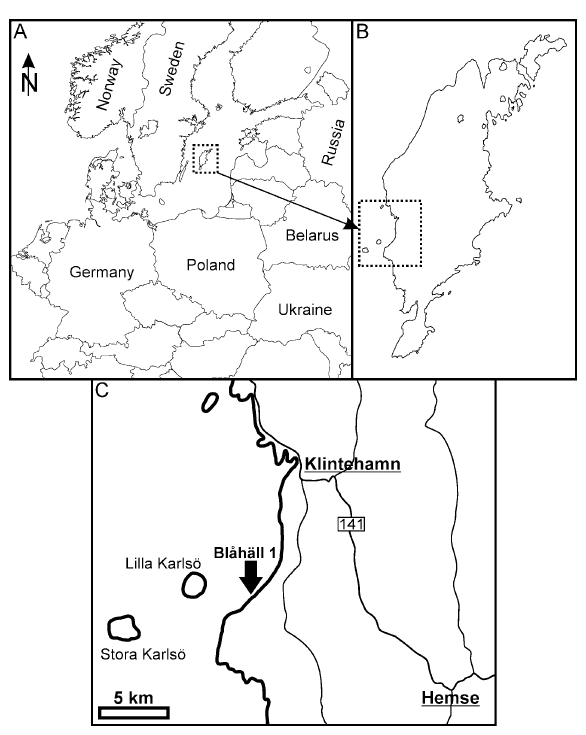
Fig. 1. Location of the sample that yielded Conchicolites crispisulcans sp. nov. All maps are own compilations based on Google Earth. A . Political map showing the position of Gotland. B . Gotland outline; the dashed line shows the location of the close-up map in C. C . Position of the Bl(cid:229)h(cid:228)ll 1 locality.